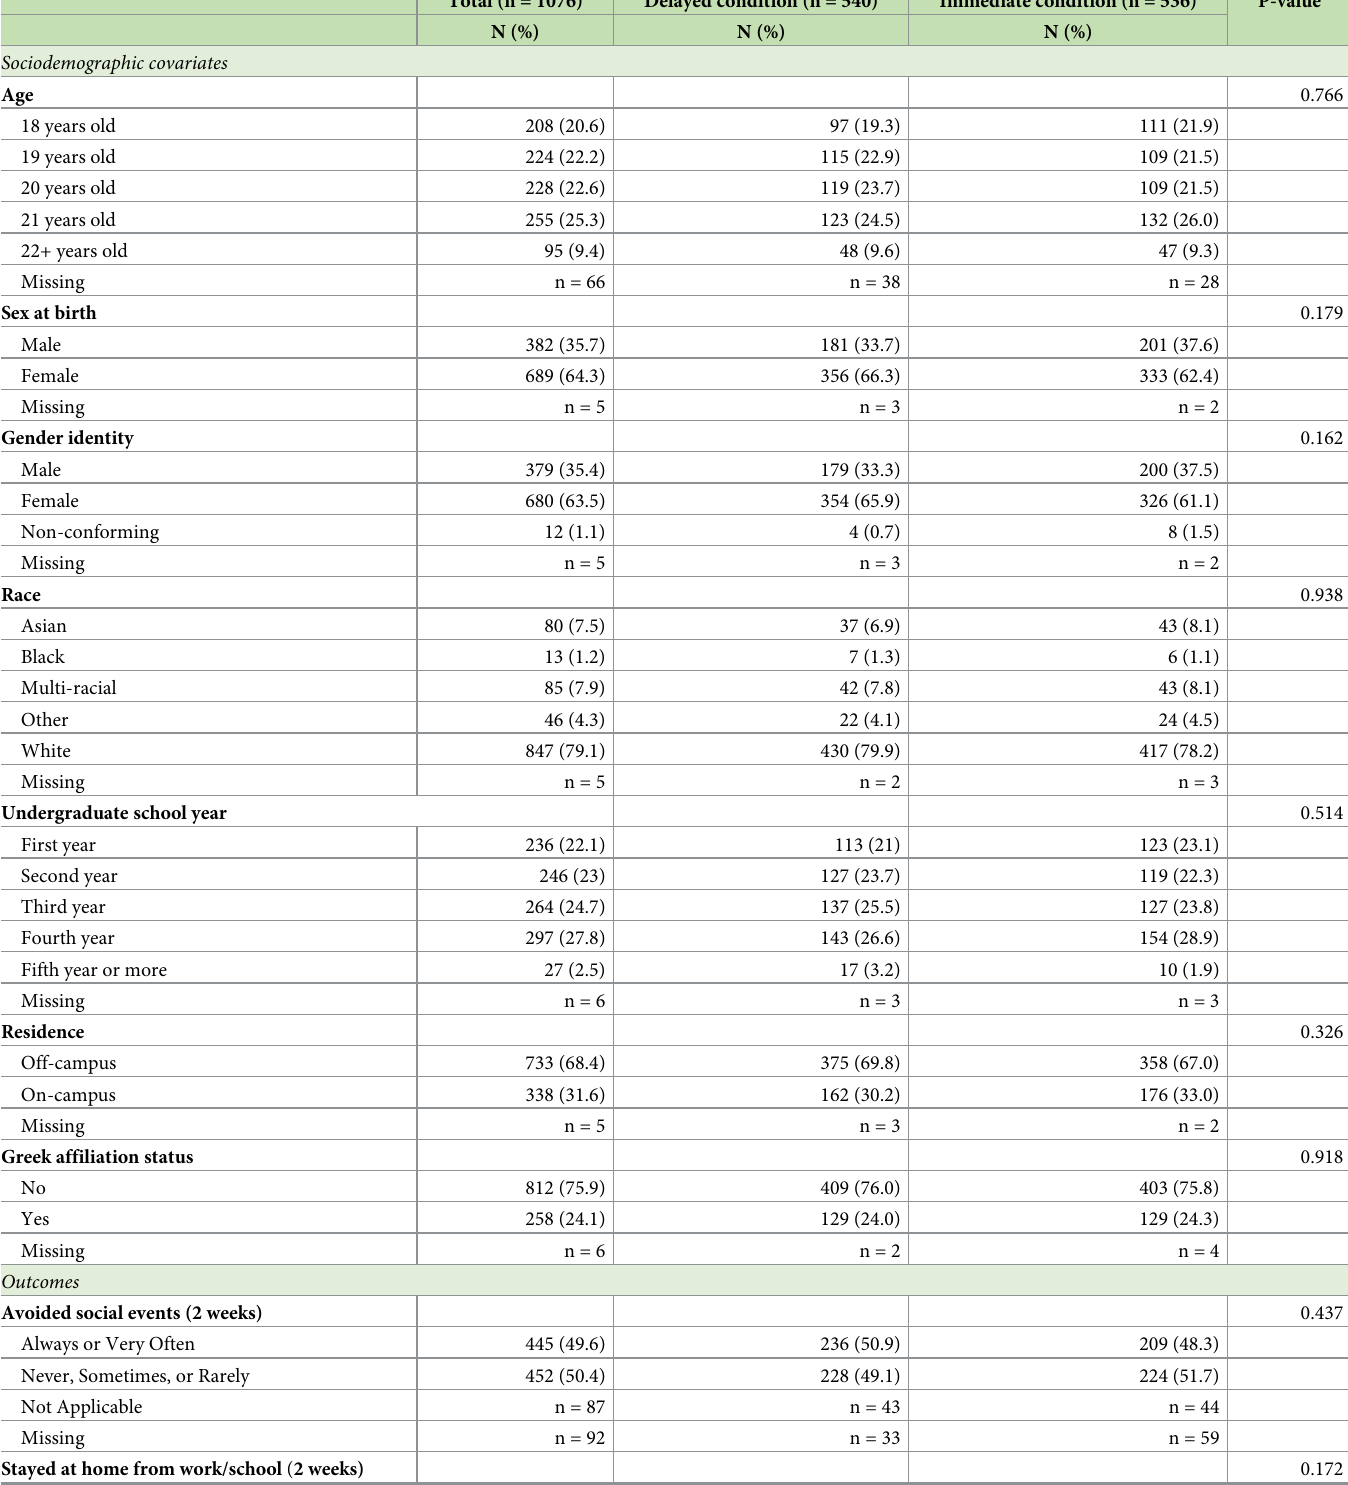
Table 1. Characteristics of the n = 1076 Indiana University undergraduate students enrolled in the trial, Fall